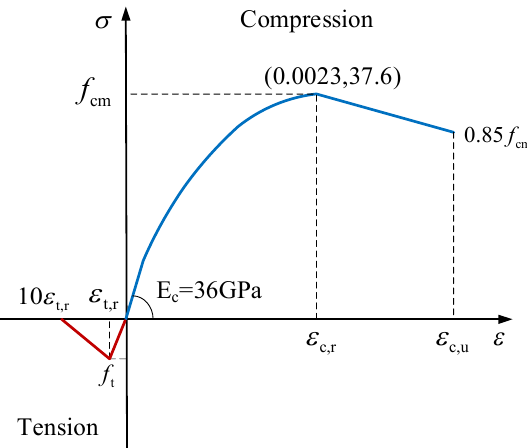
Figure 7. Constitutive relationship of the normal concrete.